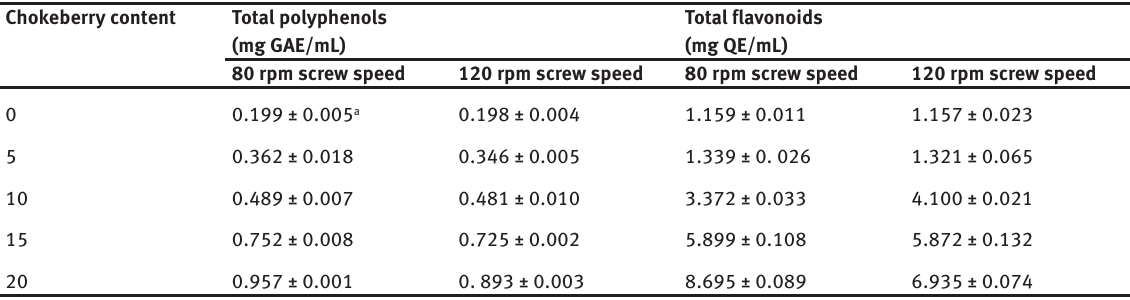
Table 2: Total polyphenols and total flavonoids content. Chokeberry